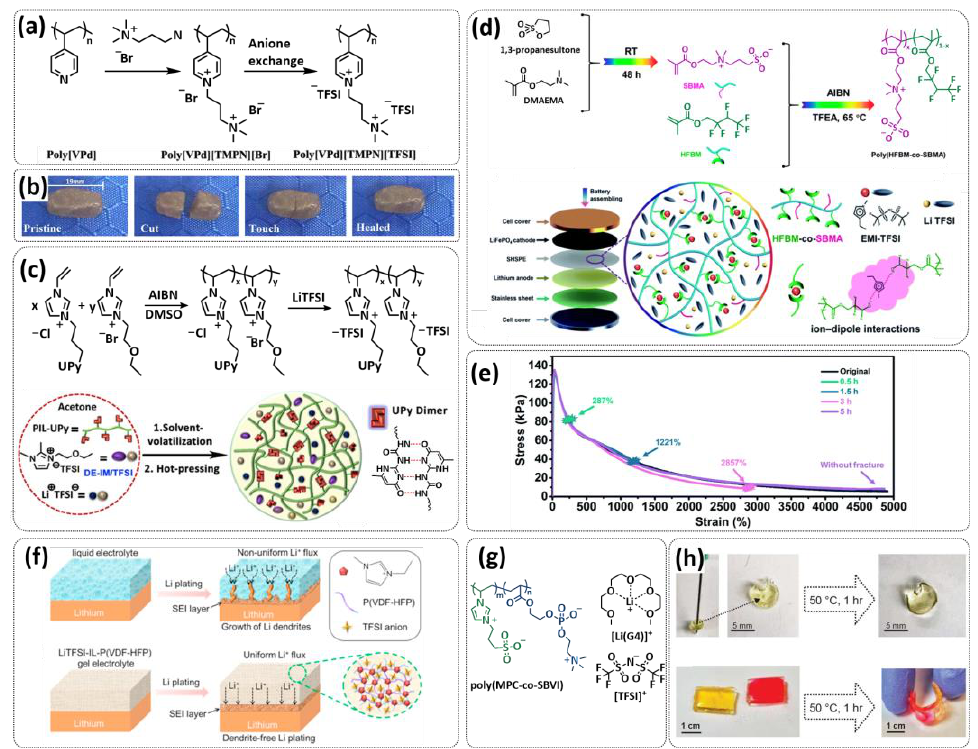
Figure 9. ( a ) Synthesis route towards self-healing PVT polymeric ionic liquid. ( b ) Photographs of the PVT-40%EMITFSI electrolytes during the self-healing process. Reproduced with permission from [96]. Copyright © 2019, Elsevier B.V. All rights reserved. ( c ) Schematic illustration of the synthesis of the PIL-UPy copolymers and the preparative process of the ionogel membranes. Reproduced with permission from [95]. Copyright © 2019, American Chemical Society. ( d ) Synthetic route towards poly(HFBM- co -SBMA), schematic illustration of the configuration of the Li/poly(HFBM- co -SBMA) ionogel/LiFePO 4 cell and self-healing mechanism of poly(HFBM- co -SBMA) ionogel. ( e ) Tensile curves of poly(HFBM- co -SBMA) ionogel at various self-healing times at room temperature. Reproduced from Reference [93] with permission from the Royal Society of Chemistry. ( f ) Schematic illustration of the electrochemical deposition behavior of lithium metal anodes with: liquid organic solution electrolyte (above) and LiTFSI-IL-P(VDF-HFP) gel electrolyte (below). Reproduced with permission from [92]. Copyright © 2018, Elsevier B.V. All rights reserved. ( g ) Molecular structure of (Li(G4)) + , TFSI − anion and fully zwitterionic copolymer scaffold consisting of MPC and SBVI monomers. ( h ) Self-healing behavior of zwitterionic ionogel. Reproduced with permission from [97] Copyright © 2019, American Chemical Society.